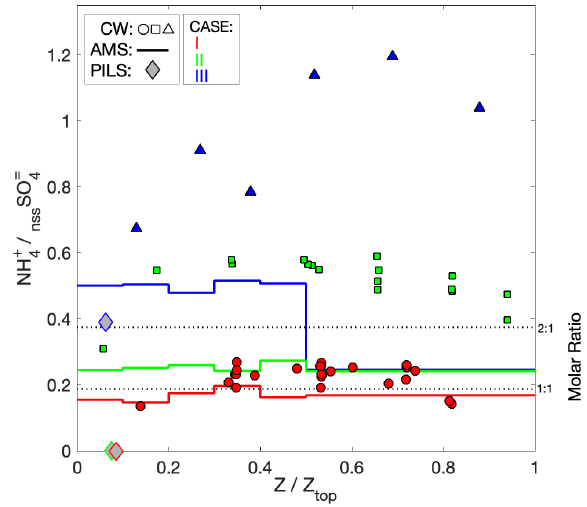
+ : nss SO 2 − for each case. Also 4 4